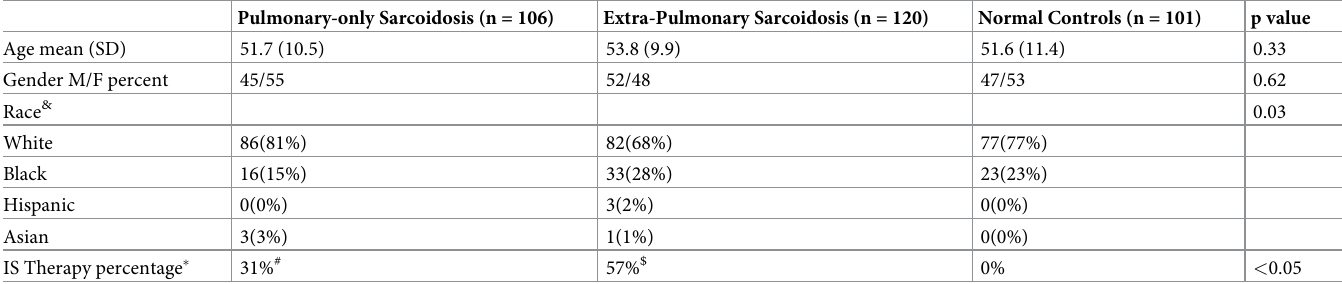
Table 1. Demographics of the study cohorts. Pulmonary-only Sarcoidosis (n = 106)